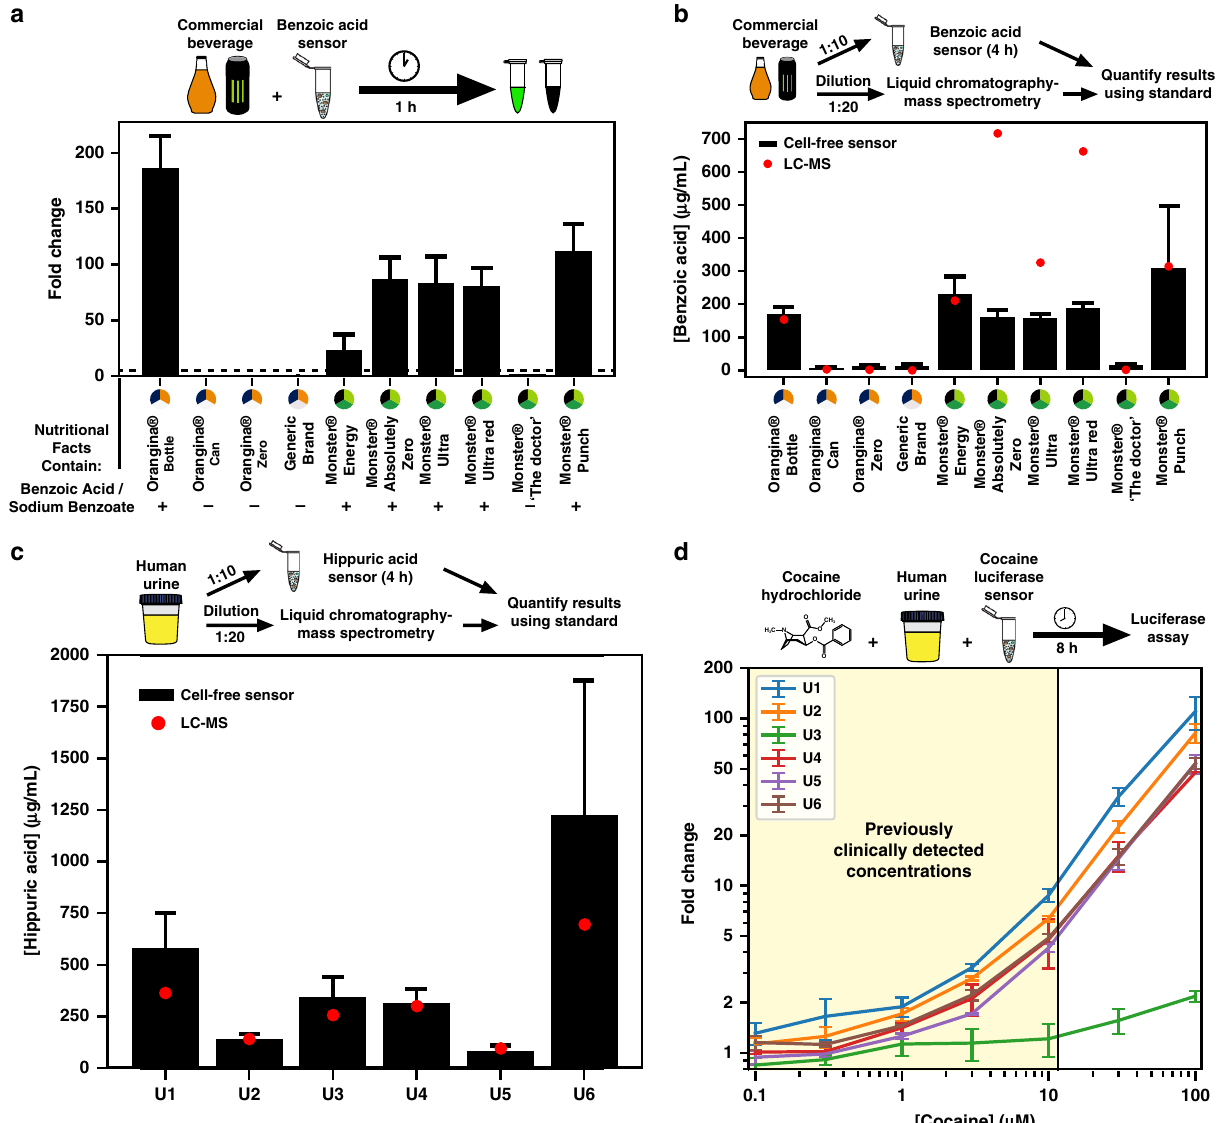
Fig. 4 Detecting benzoic acid, hippuric acid, and cocaine in complex samples. a Cell-free benzoic acid sensor can detect benzoates in commercial beverages. Addition of an array of different orange and energy drinks to the optimized benzoic acid biosensor produces up to ~180 fold-change response relative to the negative control with water after 1h incubation at 37°C. The test showed 100% speci fi city and sensitivity to detection of benzoates based on their inclusion in the ingredient label using a fold change of 5 as the cut-off point (dashed line). b Benzoic acid sensor is capable of quantifying the concentration of benzoic acid in different beverages. Beverages were added at 1:10 dilution to cell-free reactions for 4h and the benzoic acid concentration was determined using a calibration curve (Supplementary Fig. 10). Results were compared with those determined by LC-MS. c Endogenous hippuric acid in urine can be quanti fi